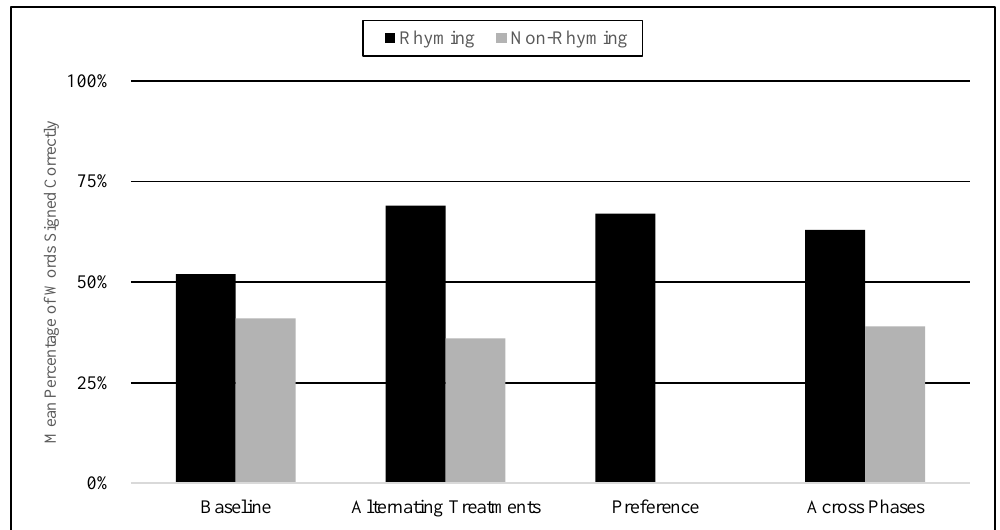
Figure 4. Mean Percentage of Words Signed Correctly in Rhyming and Non-Rhyming Conditions in Each Phase and Across Phases.